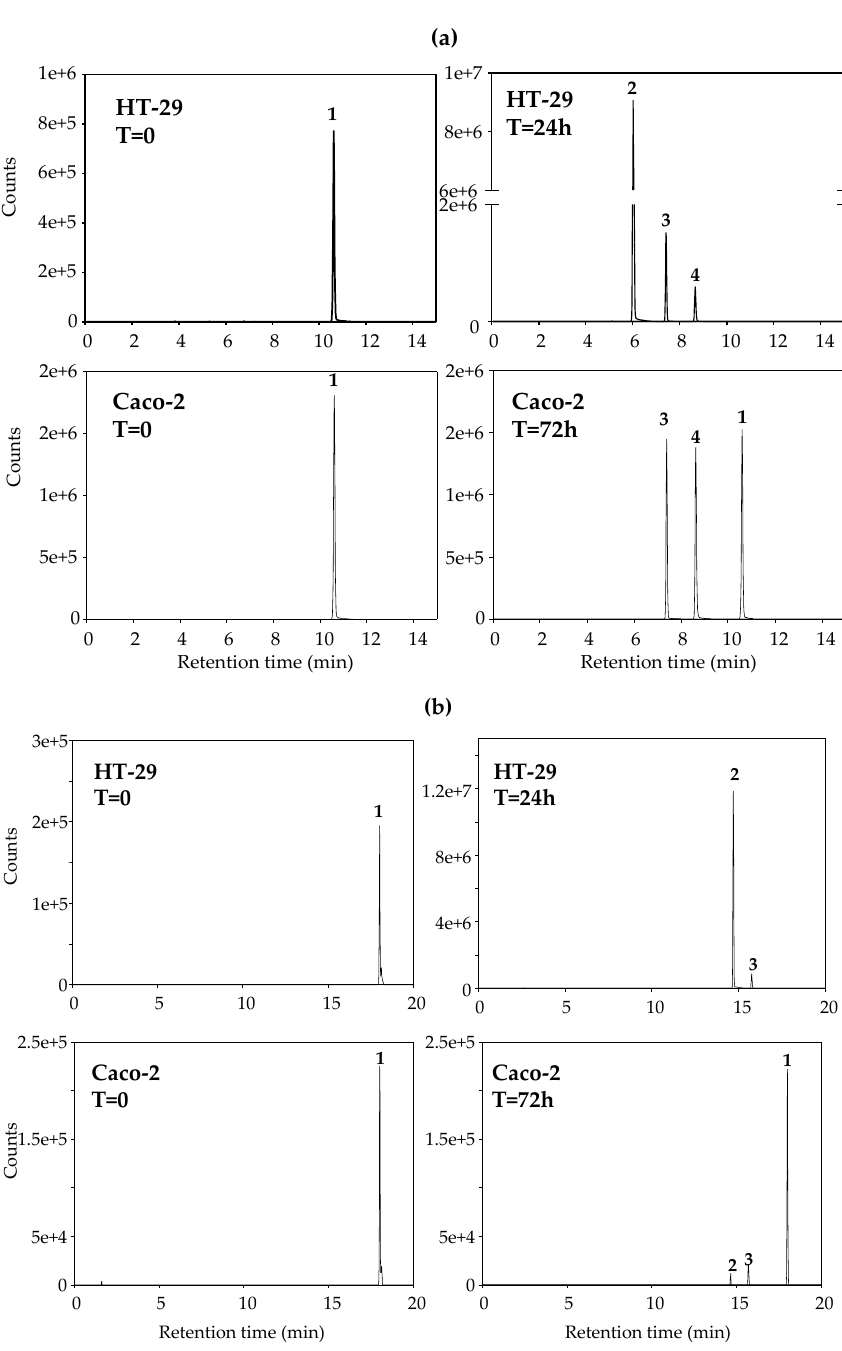
Figure 3. Extracted ion chromatograms showing the phase-II metabolism of (RSV) ( a ) and 4-hydroxy- trans -stilbene (4HST) ( b ) by HT-29 (0 and 24 h) and Caco-2 cells (0 and 72 h). ( a ): RSV ( 1 , m / z − 227.0714), RSV 4 ′ - O -glucuronide ( 2 , m / z − 403.1035), RSV 3- O -glucuronide ( 3 , m / z − 403.1035), and RSV 3- O -sulfate ( 4 , m / z − 307.0282); ( b ): 4HST ( 1 , m / z − 195.0815), 4HST- O -glucuronide ( 2 , m / z − 371.1136), and 4HST- O -sulfate ( 3 , m / z − 275.0384). While 100% RSV was metabolized by HT-29 cells after 24 h, only 14% RSV was me-